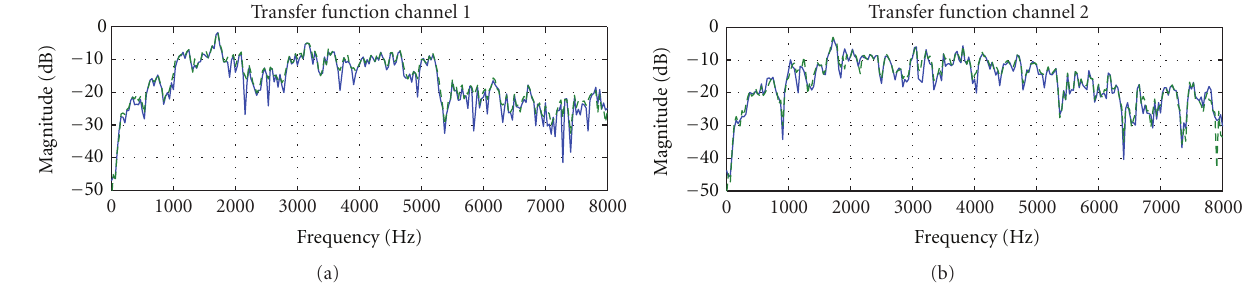
Figure 11: Estimated (dashed line) and actual transfer functions for the two